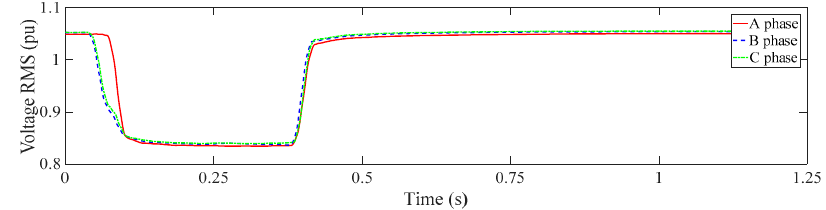
Figure 3. Typical voltage RMS waveform of a three-phase short circuit.